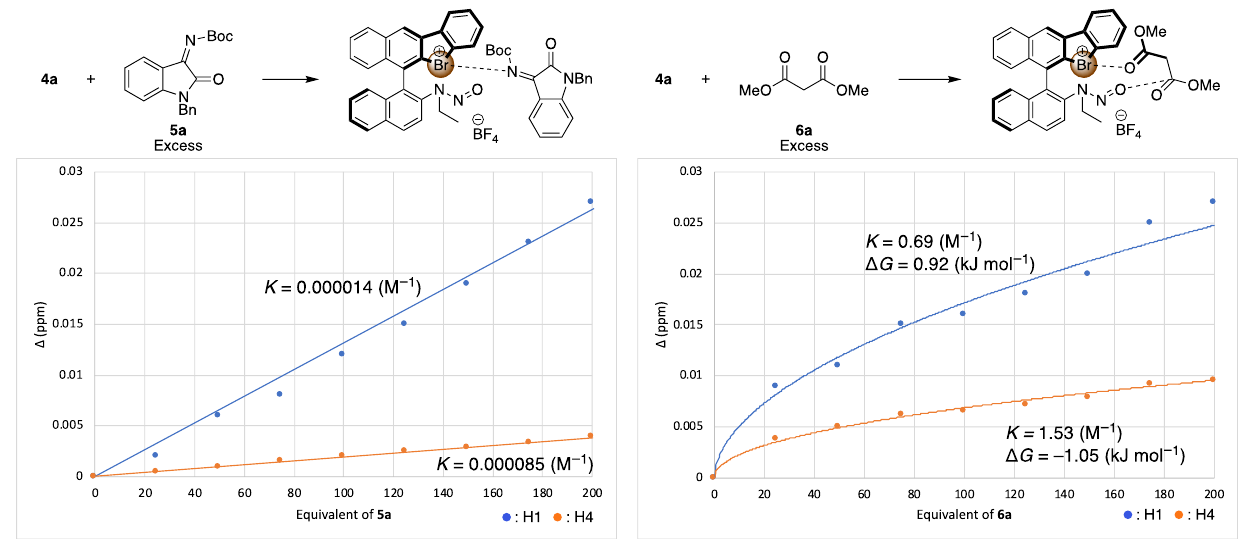
Figure 5. 1 H NMR titration experiments (in CDCl 3 ) of 4a with 5a ( left ), and 6a ( right ). The spots show the chemical shift differences from additive-free values at various equivalent of additives. Blue spot means the chemical shifts differences for H1, and the orange spot means that of H4 (Figure 4). The binding constants K were calculated by Bindfit.